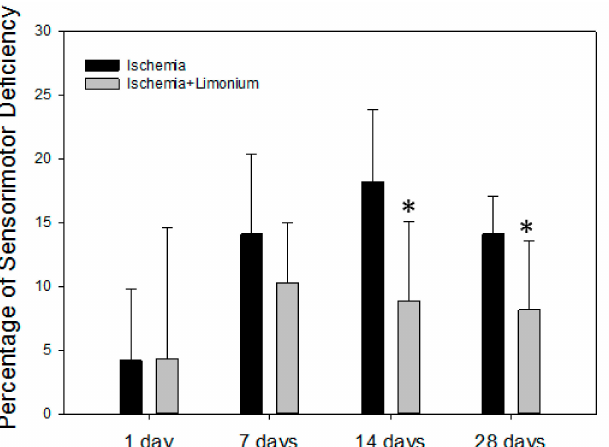
Figure 7. L. gmelinii extract improves motor coordination of rats with induced ischemic stroke after 14 and 28 days of treatment. The percentage of motor deficiency was calculated and normalized to the control trials (before surgery, represented as a 0 point). *— p ≤ 0.05 compared to the animals with ischemia